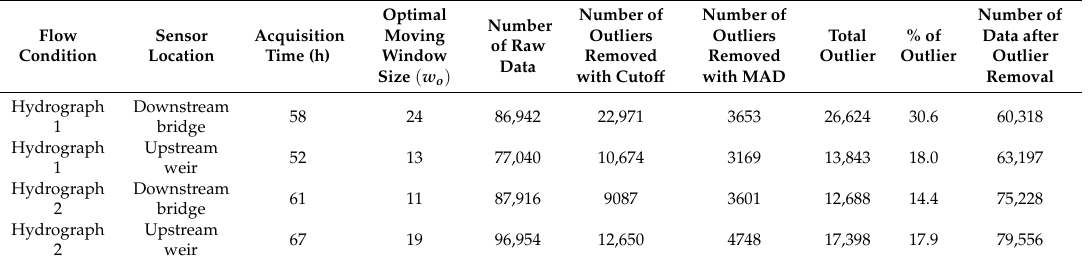
Table 1. Results of outlier detection for each data set and moving window size for median absolute deviation (MAD)